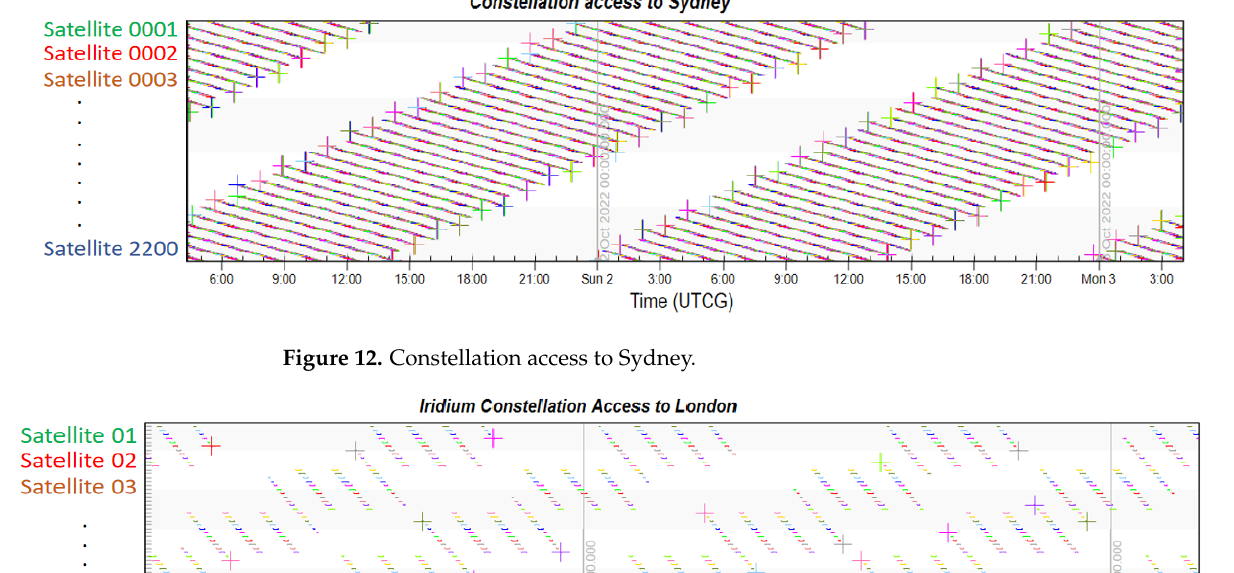
Figure 12. Constellation access to Sydney.